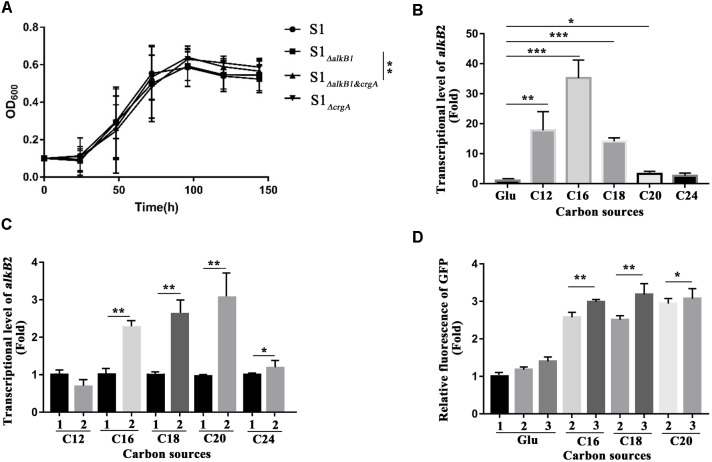
Cell growth detection, the transcription and expression analysis of alkB2 gene in wild-type strain and mutant strains. (A) The growth curves of different strains cultured with n-octadecane as sole carbon source. Wide type SJTD-1 strain (S1, •), the alkB1-knockout strain (S1 ΔalkB1, ), the crgA-knockout strain (S1 ΔcrgA, ), and the alkB1/crgA double knockout strain (S1ΔalkB1&crgA, ) were detected. The concentration of C18 was 500 mg/L and the initial concentration of strains was OD600 = 0.1. At least five independent experiments (three paralleled samples in each experiment) were conducted and the average values were calculated with standard errors. The statistical analysis were performed with the cell numbers of strains at three time points (96, 120, and 144 h) and the P value was marked with star (∗P-value < 0.1; ∗∗P-value < 0.05; ∗∗∗P-value < 0.01). (B) The transcriptional levels of alkB2 gene in strain SJTD-1 cultured with glucose and different alkanes (C12–C24). The transcriptional level of alkB2 gene in glucose (Glu) was set as 1.0. At least five independent experiments (three paralleled samples in each experiment) were conducted and the average values were calculated with standard errors. The statistical analysis were performed with the transcriptional levels of alkB2 gene in strain SJTD-1 cultured with glucose and different same n-alkane, and marked with star (∗P-value < 0.1; ∗∗P-value < 0.05; ∗∗∗P-value < 0.01). (C) The transcriptional levels of alkB2 gene in the wild-type strain SJTD-1 and strain S1ΔcrgA cultured with different alkanes (C12–C24). 1 represented strain SJTD-1, and 2 represented strain S1ΔcrgA. The transcriptional levels of alkB2 gene in strain SJTD-1 cultured with the corresponding n-alkanes was set as 1.0, respectively. At least five independent experiments (three paralleled samples in each experiment) were conducted and the average values were calculated with standard errors. The statistical analysis was performed with the transcriptional levels of alkB2 gene in strain S1ΔcrgA and strain SJTD-1 cultured with same n-alkane, and marked with star (∗P-value < 0.1; ∗P-value < 0.05; ∗∗∗P-value < 0.01). (D) The fluorescence of egfp gene under the promoter of alkB2 gene in strain SJTD-1 and strain S1ΔcrgA cultured with glucose and different alkanes (C16–C20). 1 was strain SJTD-1 containing plasmid pBS-eGFP; 2 was strain SJTD-1 containing plasmid pBS-PalkB2-eGFP; 3 was strain S1ΔcrgA containing plasmid pBS-PalkB2-eGFP. The GFP fluorescence in strain SJTD-1 with plasmid pBS-eGFP cultured with glucose was set as 1.0. At least five independent experiments (three paralleled samples in each experiment) were conducted and the average values were calculated with standard errors. The statistical analysis were performed with the GFP fluorescence in strain SJTD-1 containing plasmid pBS-PalkB2-eGFP (2) and that in strain S1ΔcrgA containing plasmid pBS-PalkB2-eGFP (3) cultured with same n-alkane, and marked with star (∗P-value < 0.1; ∗∗P-value < 0.05; ∗∗∗P-value < 0.01).